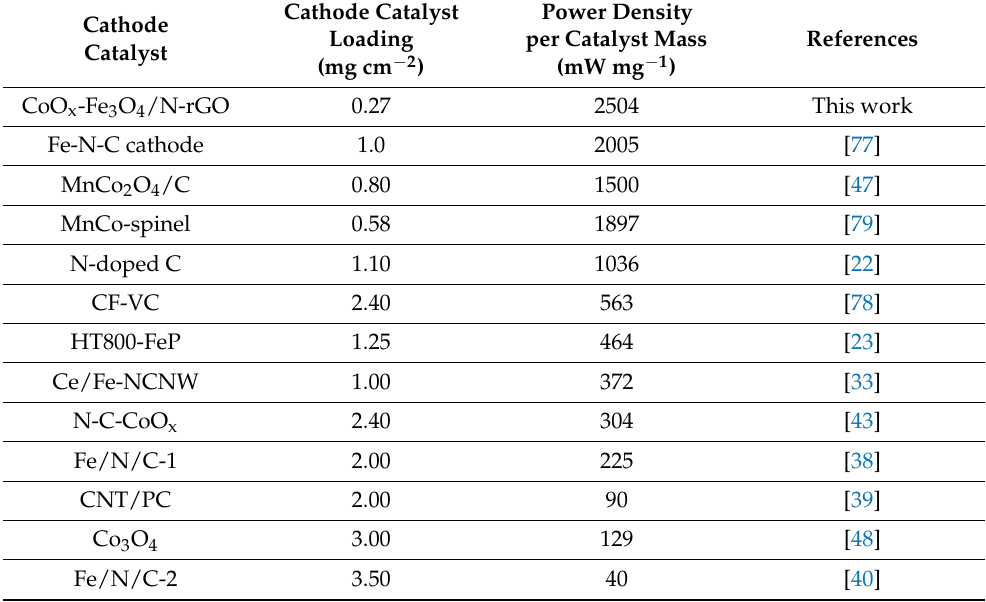
Table 2. Comparison of power density per mass for AEMFCs with PGM-free cathodes in the